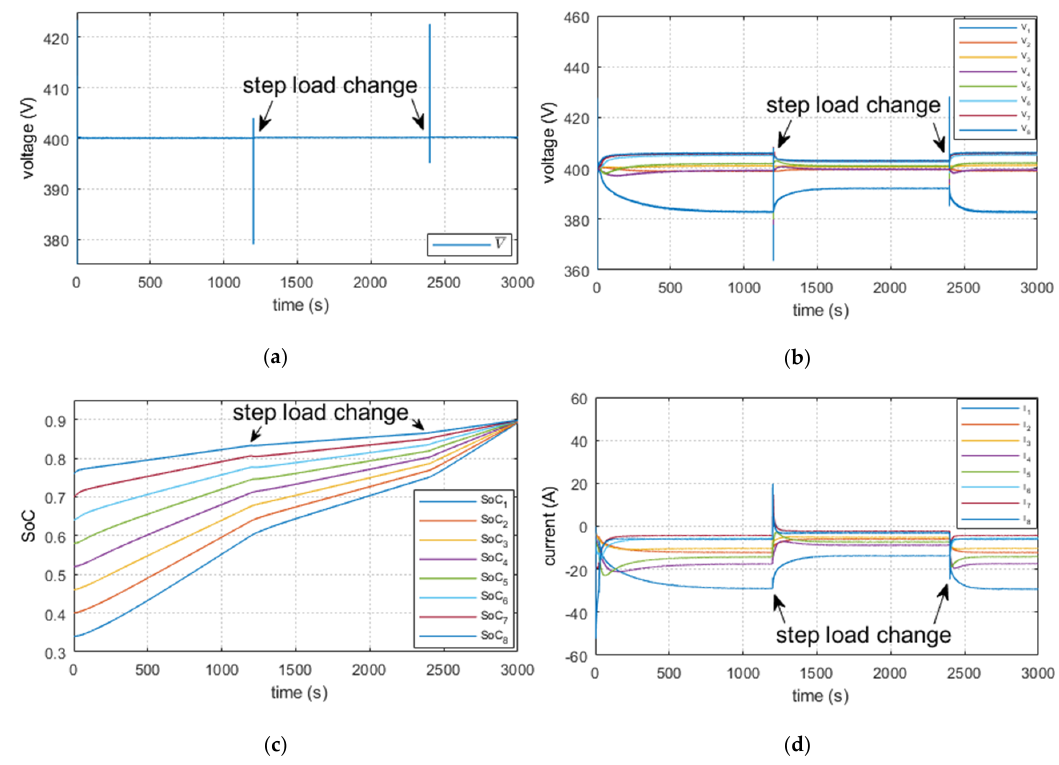
Figure 4. Discharging simulation results: ( a ) average voltage; ( b ) dynamic voltages; ( c ) SoCs; ( d ) output